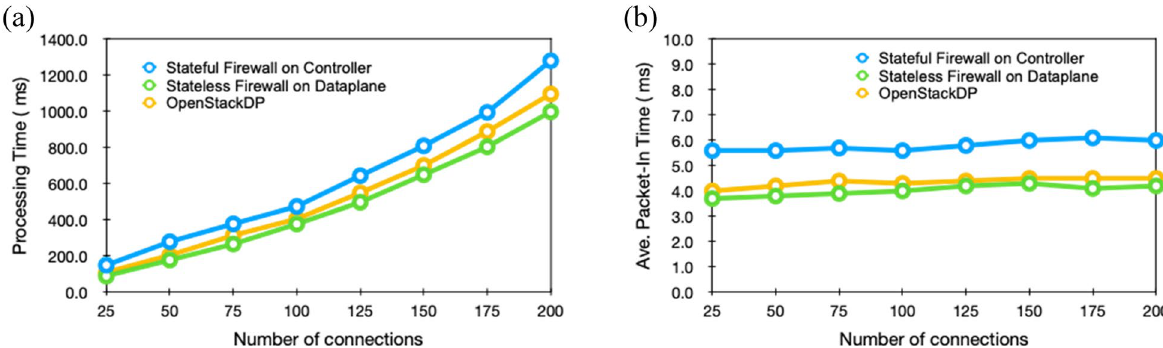
Fig. 23 Dataplane Scalability. a Processing time b Packet-In